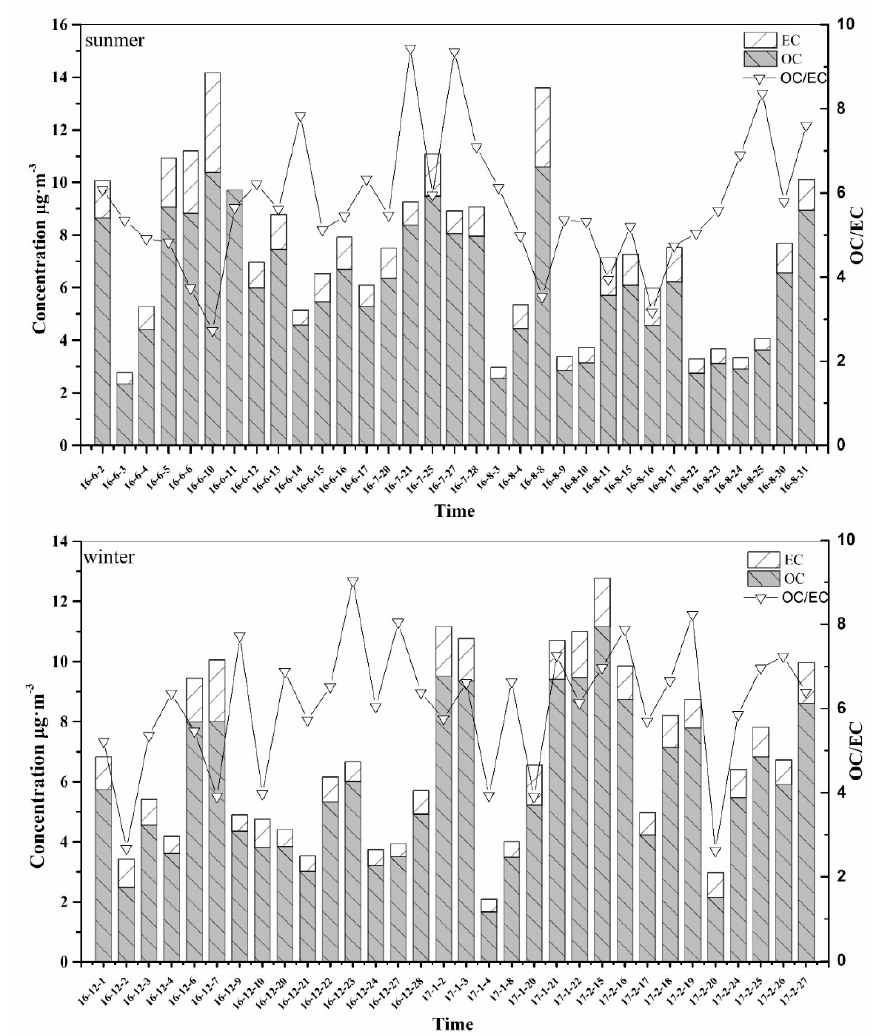
Figure 4. Changes of organic carbon (OC), elemental carbon (EC), and OC/EC ratios in PM 2.5 in summer and winter.